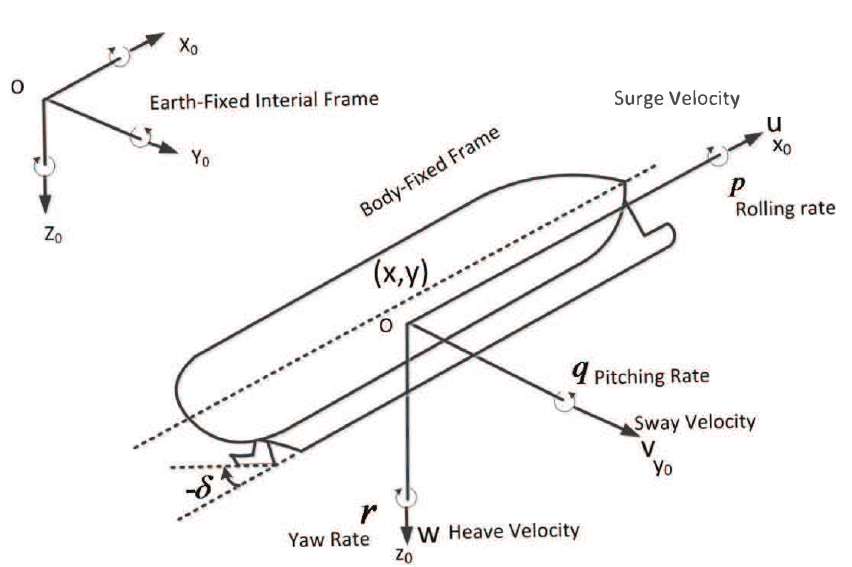
Figure 1. The Earth-fixed inertial and body-fixed